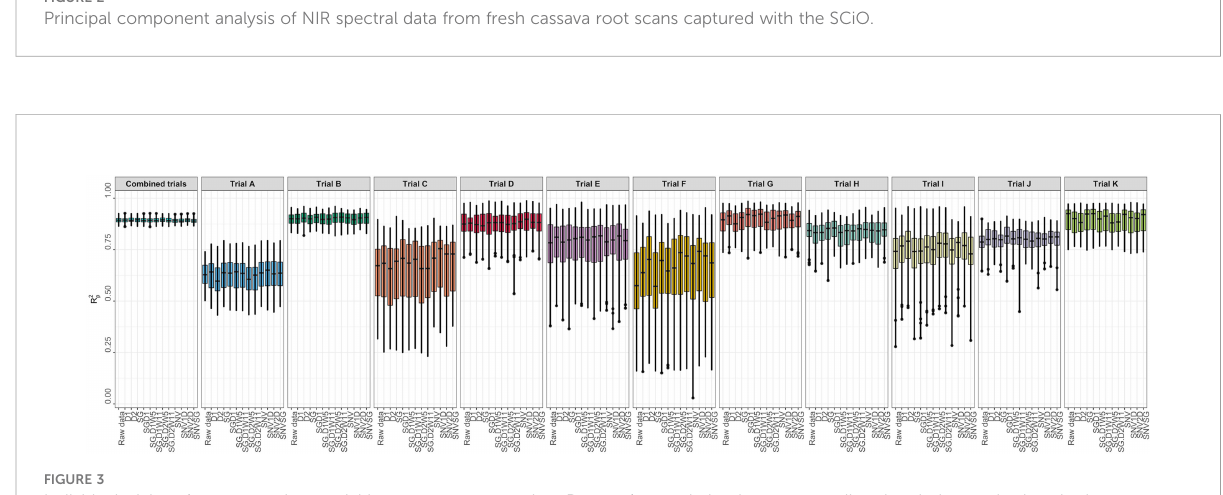
FIGURE 3 Individual trial performance using partial least squares regression. Pearson ’ s correlation between predicted and observed values in the test set (R 2 p ); no spectral pretreatment (raw data); standard normal variate (SNV); standard normal variate and fi rst derivative (SNV1D); standard normal variate and second derivative (SNV2D); fi rst derivative (D1); second derivative (D2); Savitzky-Golay with window size = 11 (SG); standard normal variate and Savitzky-Golay (SNVSG), gap segment derivative with window size = 11 (SGD1), Savitzky-Golay with window size = 5 and fi rst derivative (SG.D1W5); Savitzky-Golay with window size = 11 and fi rst derivative (SG.D1W11); Savitzky-Golay with window size = 5 and second derivative (SG.D2W5); and Savitzky-Golay with window size = 11 and second derivative (SG.D2W11).